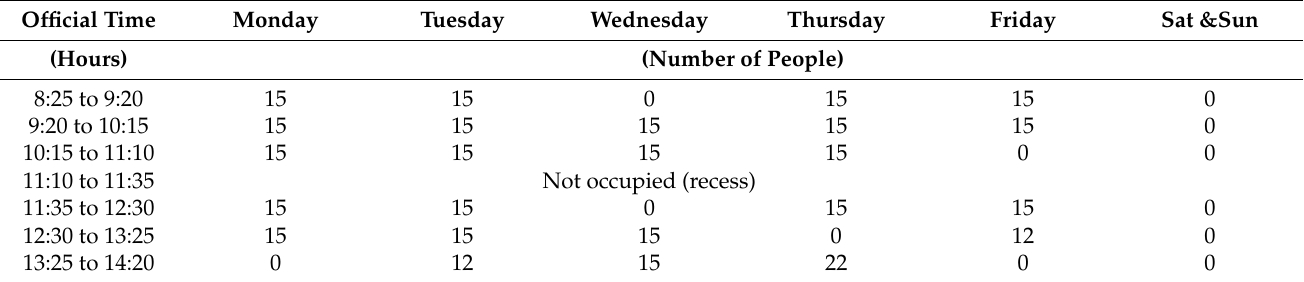
Table 2. Theoretical occupancy patterns of classroom: Academic year 2020/2021 (until 19 April